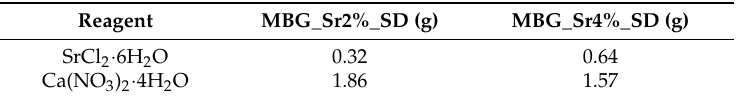
Table 1. Amounts of used salt precursors for MBG_Sr2%_SD and